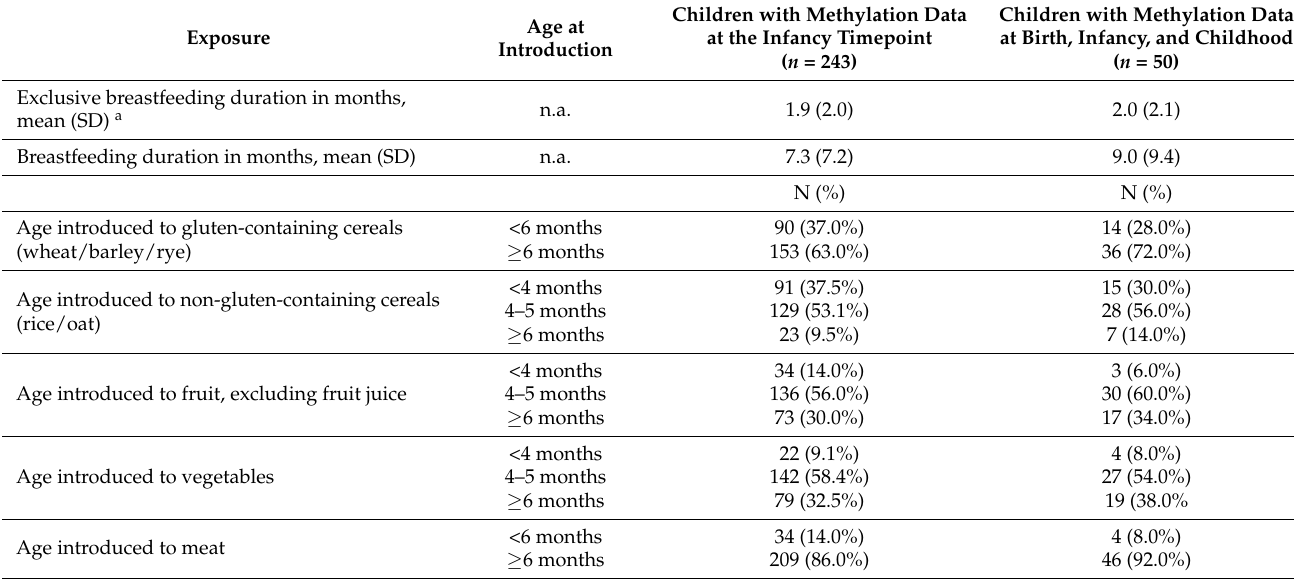
Table 2. Infant diet exposures of the children that had methylation data at the different